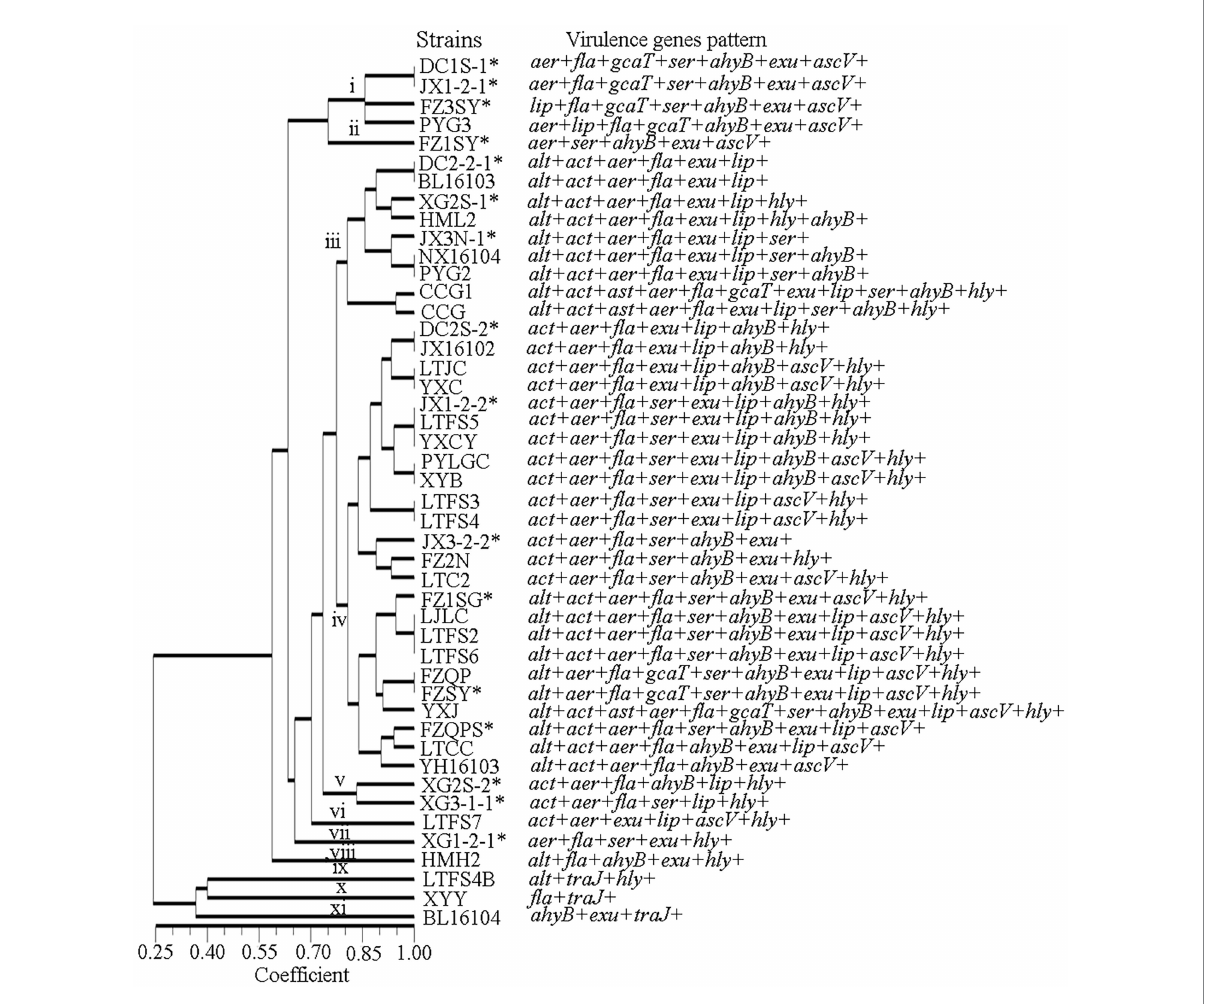
FIGURE 3 The virulence genes pattern of the A. veronii isolates used in this